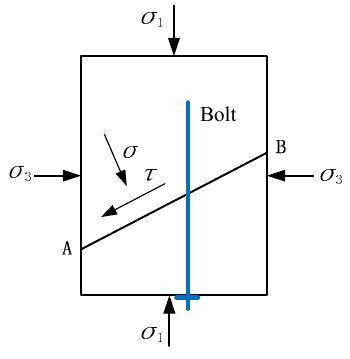
Figure 5. Mechanical model of fracture rock with bolt support.